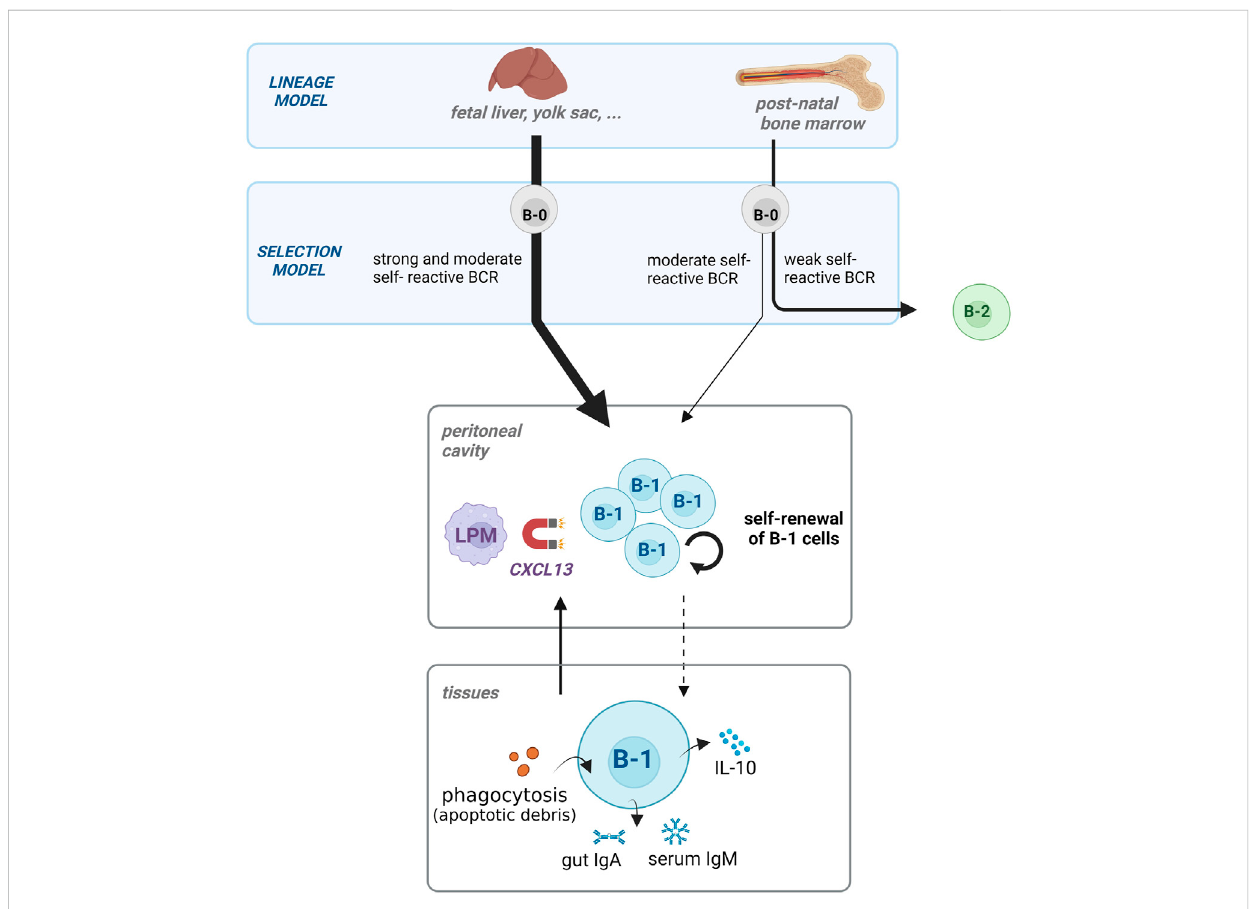
FIGURE 1 The development and function of B-1 cell pool during homeostasis. The development of B-1 cells occurs mostly in the fetus (lineage model). The bone marrow contributes only to a small addition of the B-1 cell pool in adults in contrast to B2 lymphocytes. The precursors (B-0) becoming B-1 cells have BCR with moderate or strong reactivity to self-antigens (selection model). B-1 cells are homed in the peritoneal cavity by CXCL13-releasing large peritoneal macrophages (LPM), where they self-renew. The three main functions of B-1 cells are apoptotic cell phagocytosis, IgM and IgA natural antibody production, and regulatory cytokine (IL-10) release, and contribute to maintaining homeostasis in the